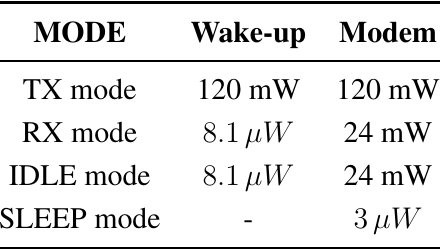
Table 4. Underwater modem energy consumption.